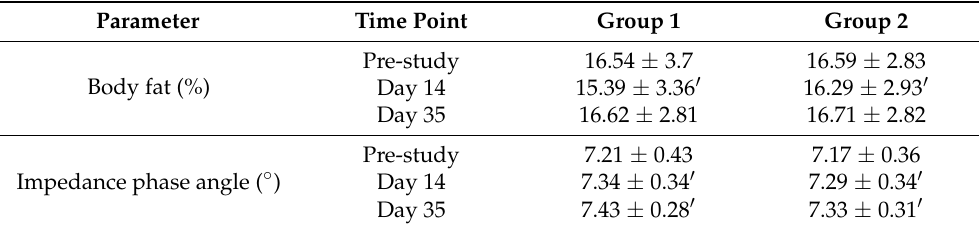
Table 2. Trends in BIA parameters of athletes by group.